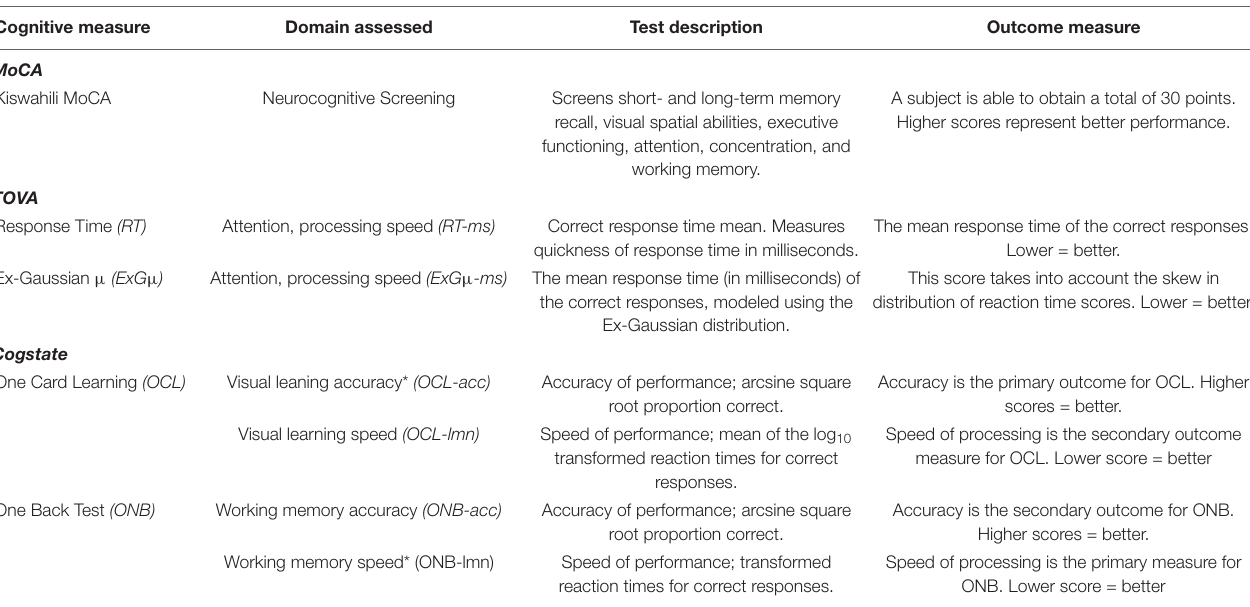
TABLE 2 | Descriptions of cognitive